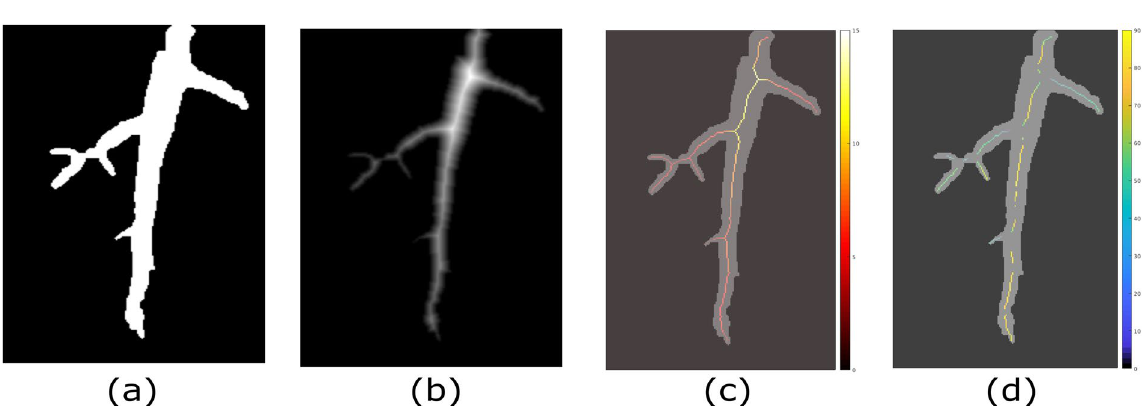
Figure 7. Visualization of root features: ( a ) binary root image, ( b ) corresponding Euclidean distance map, ( c ) overlay of the binary image with the root skeleton colored according to the local root width (gray-scale map), ( d ) overlay of the binary image with the root skeleton colored according to the local root tangent (black-yellow color